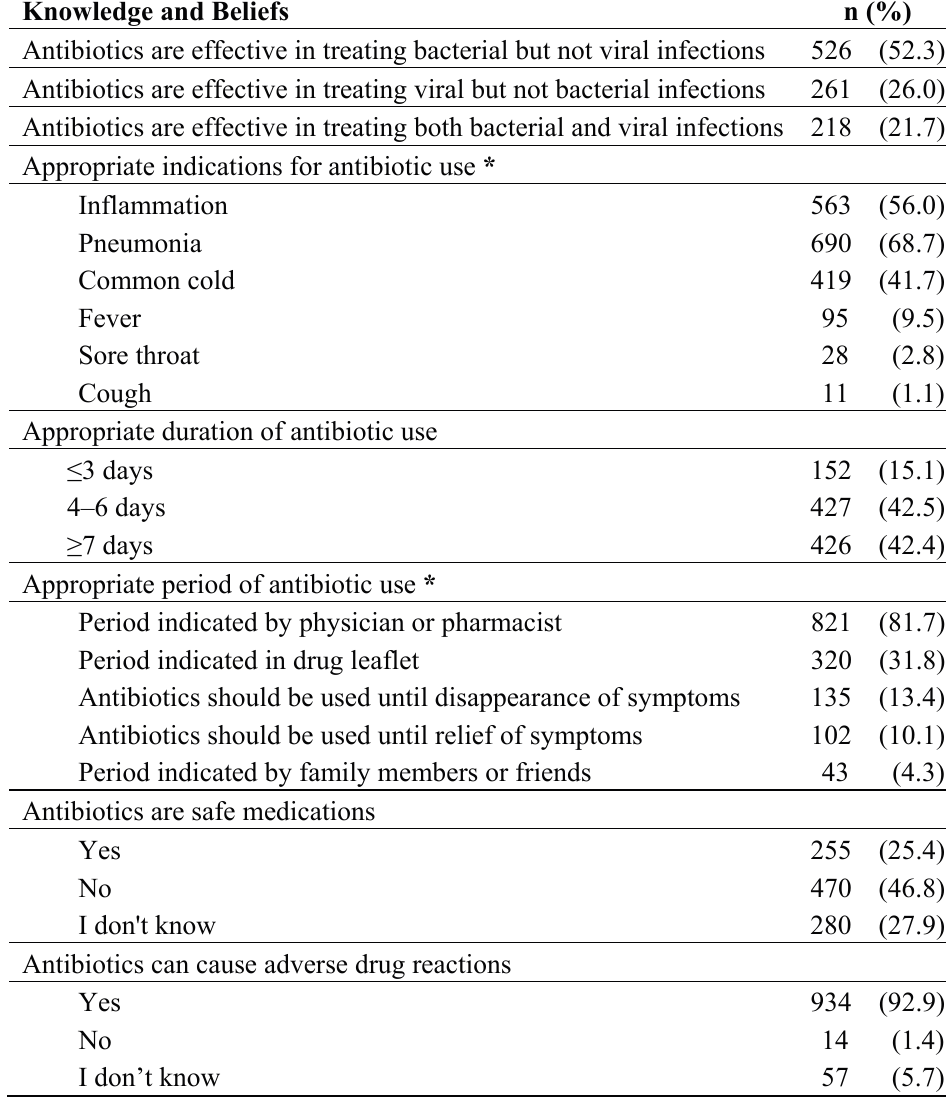
Table 3. Respondents’ knowledge and beliefs of